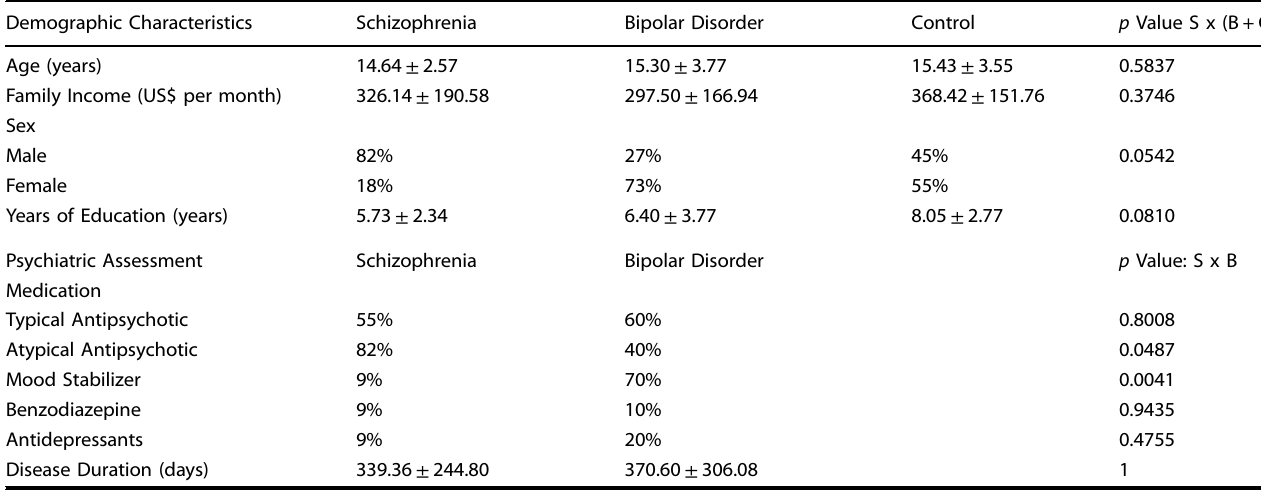
Table 1. Socio-economic and clinical information of Schizophrenia, Bipolar, and Control groups Demographic